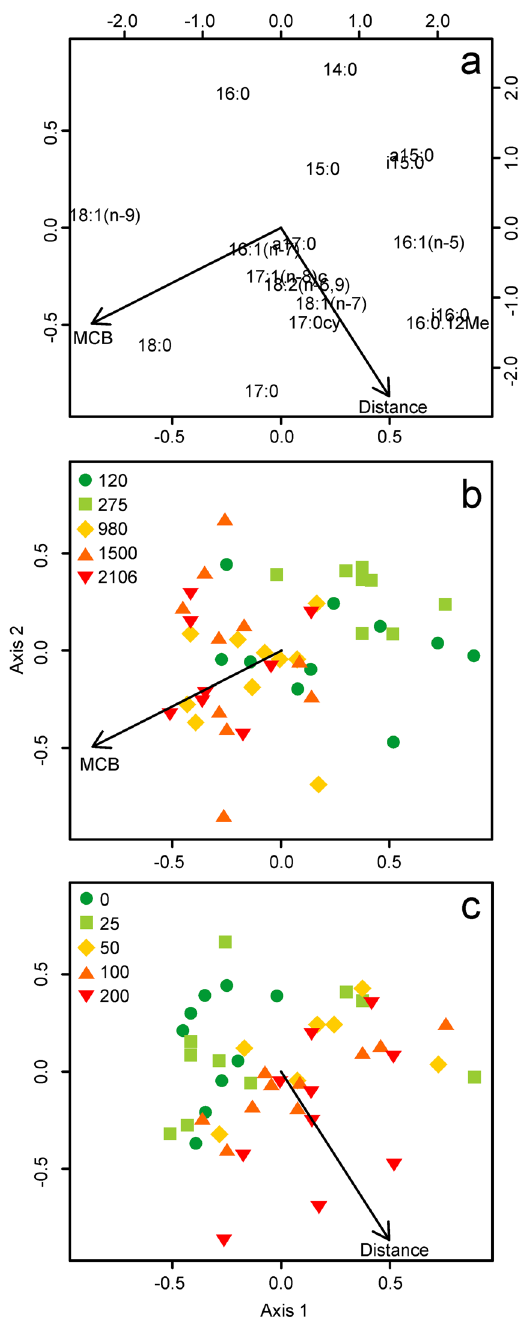
Figure 2. Redundancy analysis distance triplot of phospholipid fatty acid (PLFA) profiles (mol %) extracted from surficial sediments around 5 fish farms in Scotland. The upper panel ( a ) visualizes how the explanatory variables MCB (maximum consented biomass, tonnes) and distance from the cage edge (m), plotted on the primary axes, were related to the 17 PLFAs (‘species’), plotted on the secondary axes. The lower panels illustrate how the composition of PLFAs in each individual sediment sample (‘sites’, n = 46) was related to MCB ( b ) and Distance ( c